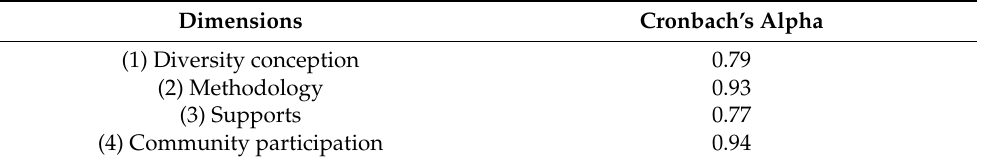
Table 6. Reliability values from The Evaluation of Teacher Preparation for Inclusion Questionnaire (CEFI-R) dimensions through Cronbach’s alpha